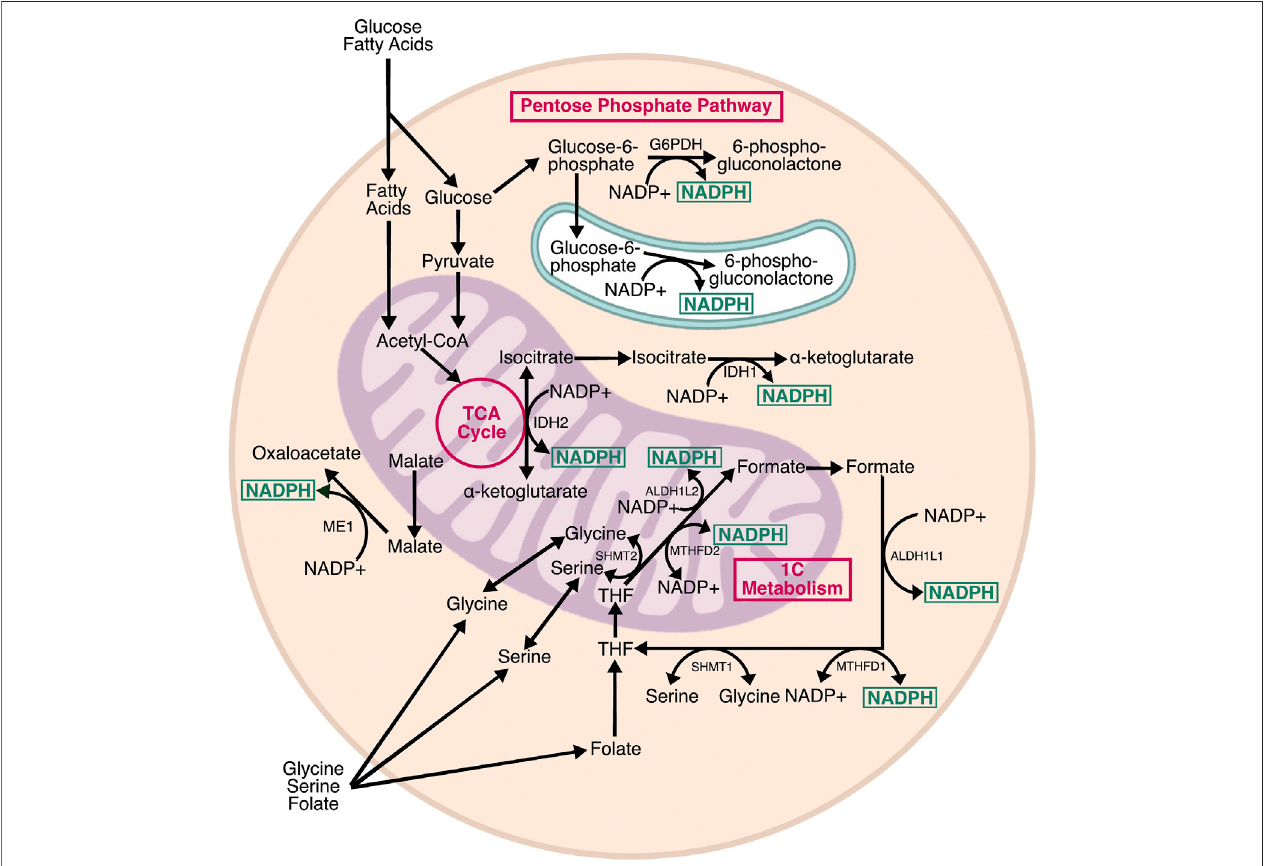
FIGURE2| PathwaysproducingNADPH.CellscontainthreesubcellularpoolsofNADPH.Inthecytosol,NADPHisproducedbyG6PD,theratelimitingstepofthe pentose phosphate pathway, as well as IDH1 and ME1, which are isozymes associated with the TCA cycle. In the mitochondria, NADPH is produced by IDH2, a TCA cycleisozyme,andtwoenzymes associatedwithonecarbon (1C)metabolism: ALDH2L1andMTHFD2. IDH1,IDH2,andMTHFD2canproceedinthereversedirection, consuming NADPH in the process. MTHFD2 can also use NAD+ as a cofactor and generate NADH. In the ER, H6PD — a homolog of G6PD — generates NADPH from glucose-6-phosphate. The relative contribution of each pathway varies by cell type, and there is evidence of crosstalk between NADPH-producing enzymes to maintain optimal NADPH levels.